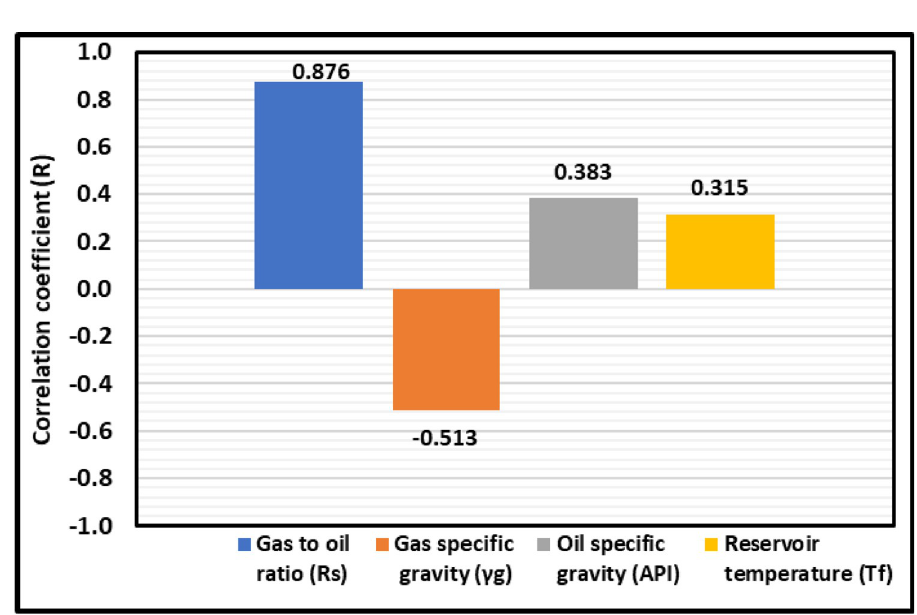
Fig 2. Relative importance of inputs with P b output.